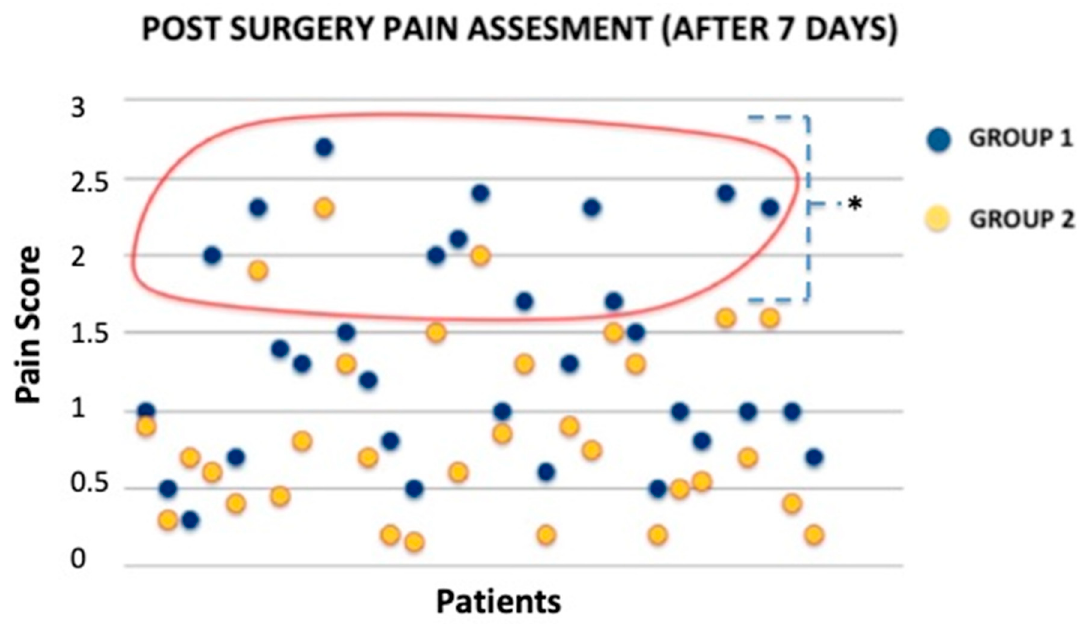
Figure 6. Comparison between both groups discomfort pain assessment after 7 days. Note that Group 1 patients have a higher Pain Score (PS) level. * p < 0.05.